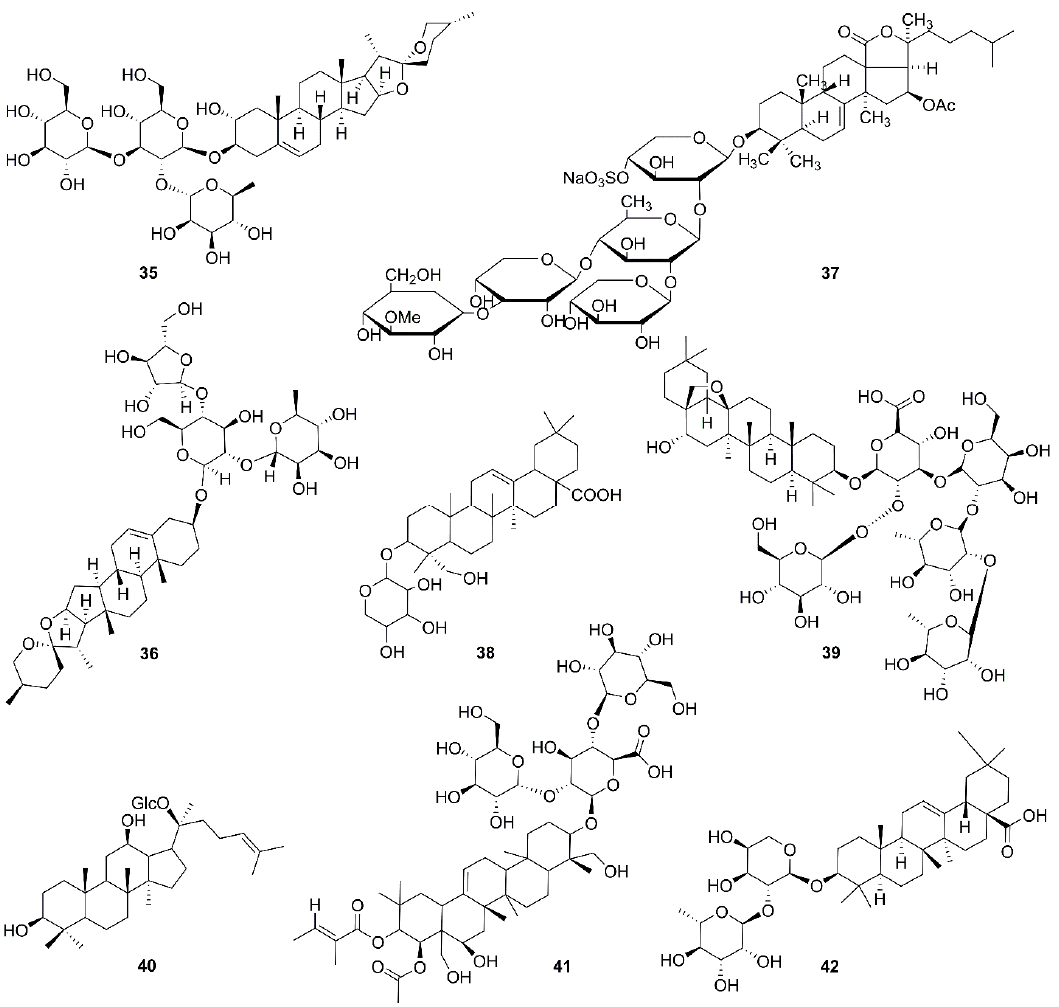
Figure 4. Chemical structures of saponins ( 35 – 42